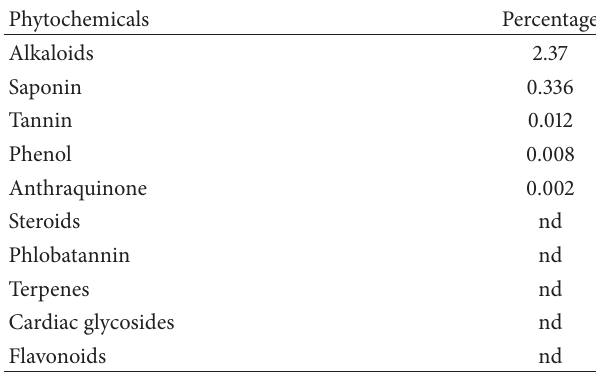
Table 2: Phytochemical constituents of the aqueous root extract of Lecaniodiscus cupanioides